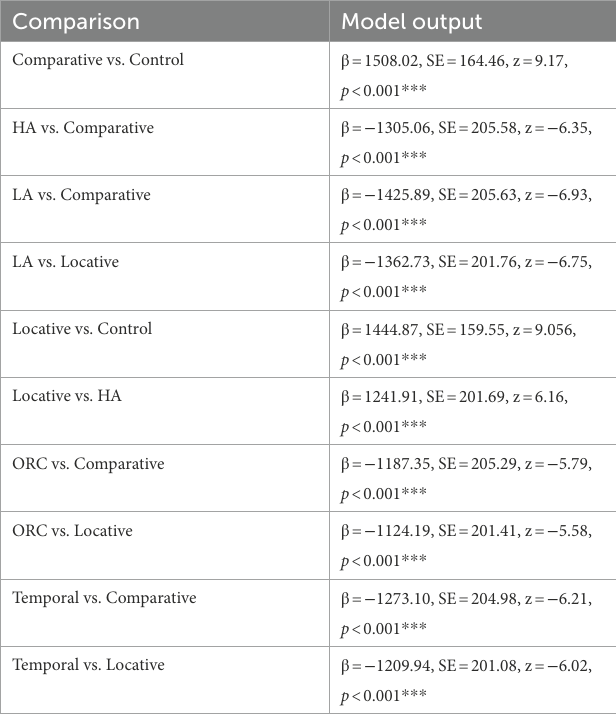
TABLE 6 Significant model outputs for question answering time analysis in Experiment